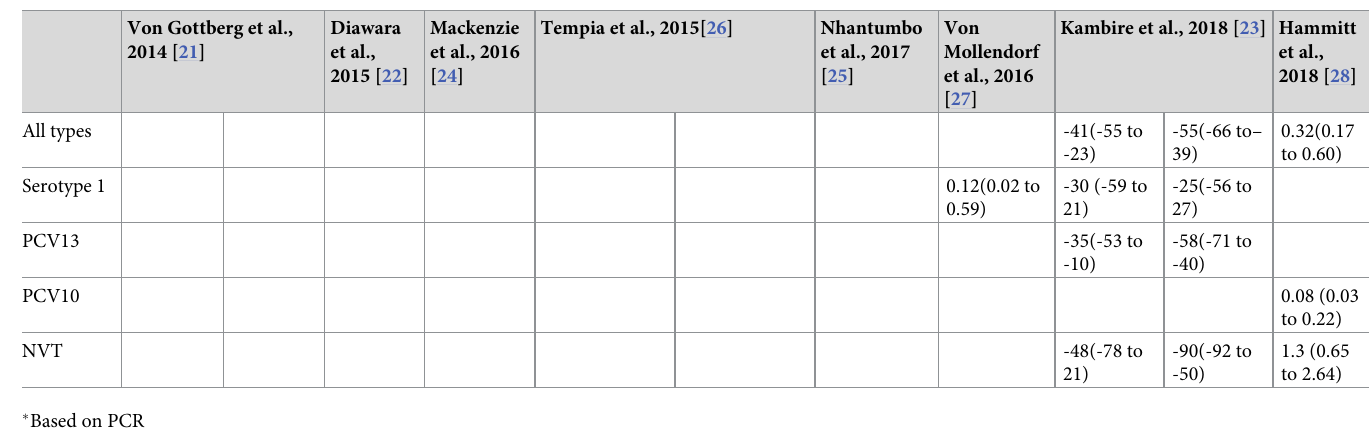
the vaccine roll out, the common vaccine serotypes were 19A (24.3%, n = 166), followed by 6A (16.2%, n = 111) and 1 (14.6%, n = 100).